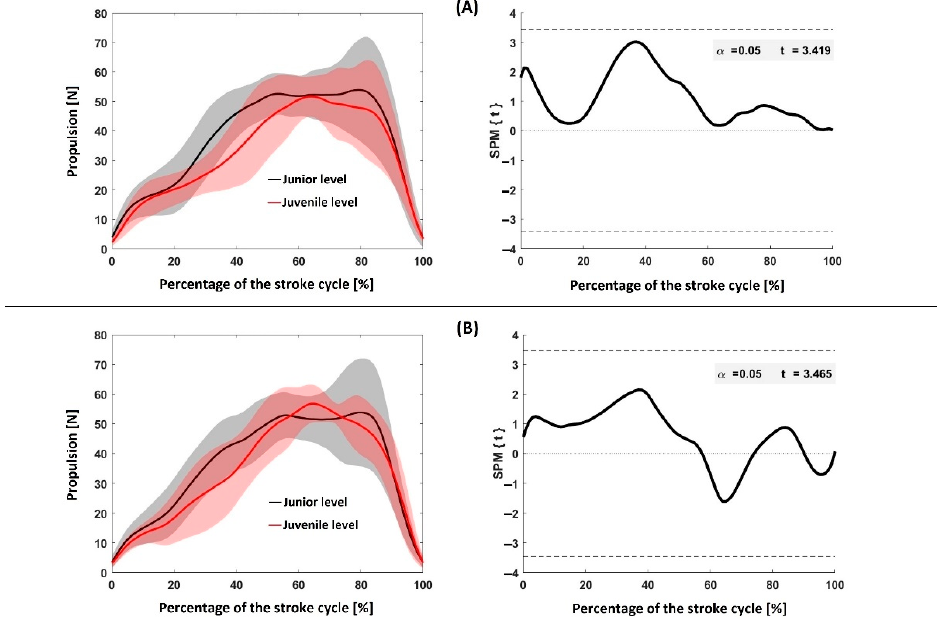
Figure 2. Comparison of propulsion–time series by SPM between and within groups. Panel ( A ): left side—mean and one standard deviation for the junior and juvenile dominant upper limb propulsion–time curve; right side—correspondent SPM comparison. Panel ( B ): left side—mean and one standard deviation for the junior and juvenile non-dominant upper limb propulsion–time curve; right side—correspondent SPM comparison. SPM {t}— t -test statistic for a statistical parametric mapping. Dashed lines represent the 95% confidence intervals (95CI).